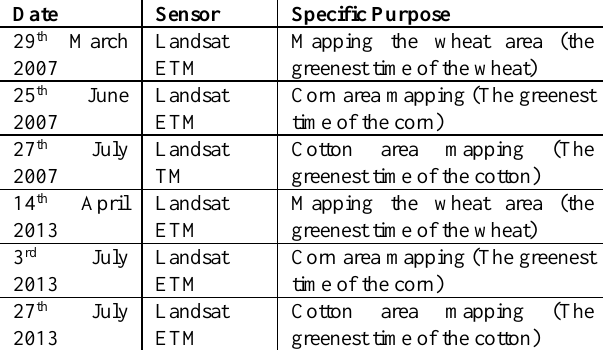
Table 1. Multi-temporal Landsat dataset used in this study